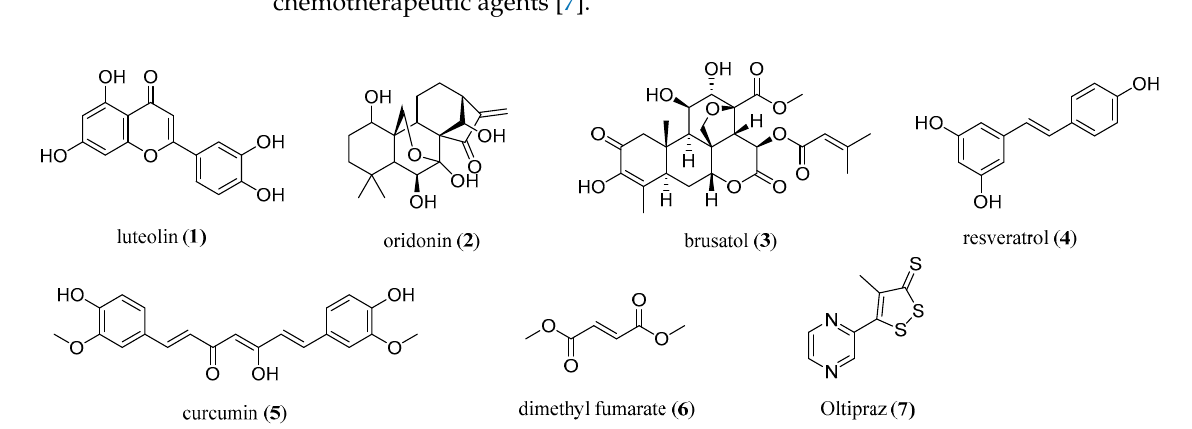
Figure 1. The most common natural ( 1 – 5 ) and synthetic ( 6 , 7 ) NRF2